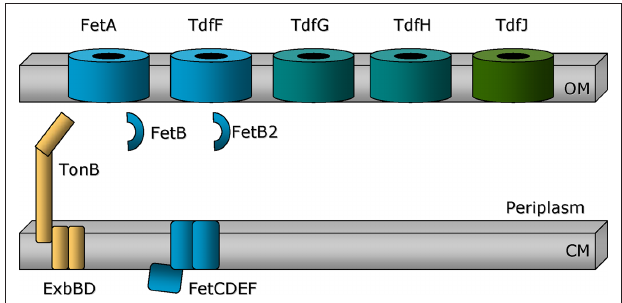
Figure 4 | Single component iron transport systems. FetA and the uncharacterized TonB-dependent transporters (TdfF, TdfG, TdfH, and TdfJ) are shown as barrels traversing the outer membrane. TonB, ExbB, and ExbD (gold) are depicted as attached to or imbedded within the cytoplasmic membrane (CM). The periplasmic binding protein FetB is encoded downstream of FetA and is expected to transport ferric-siderophores across the periplasm to a cytoplasmic membrane permease. Genes located immediately downstream of that encoding FetB are hypothesized to fulfill this function. Encoded near TdfF is a putative periplasmic binding protein annotated as FetB2, reflecting its sequence similarity